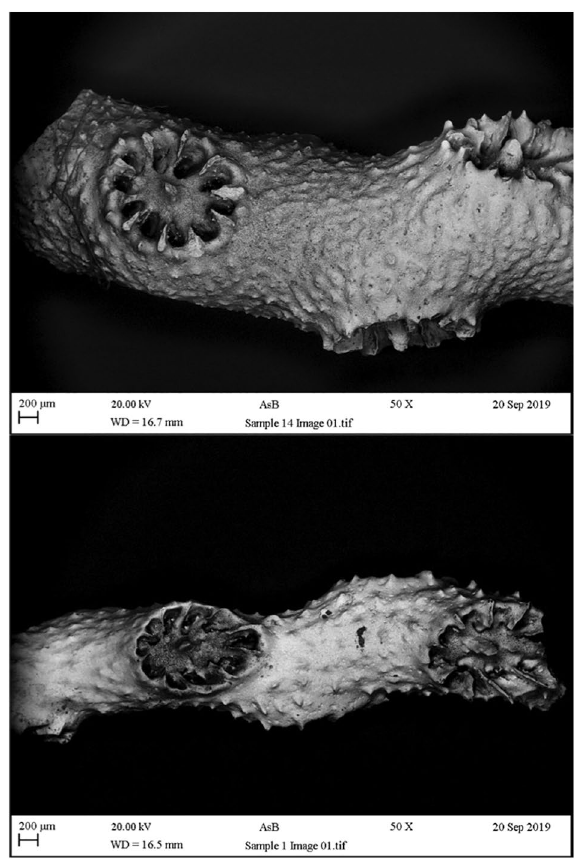
Figure 1. Scanning electron microscopy-SEM in samples from PNNCP . Top: general view sample identified as M. myriaster . Bottom: general view sample identify as M. cf.